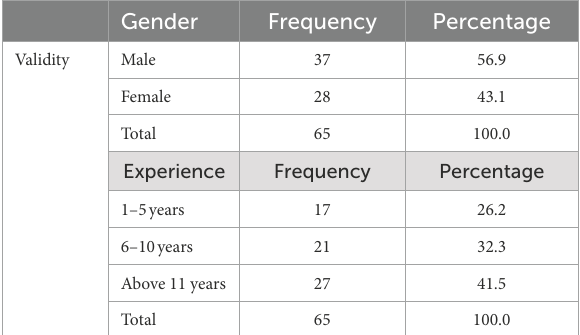
TABLE 1 Distribution of the study